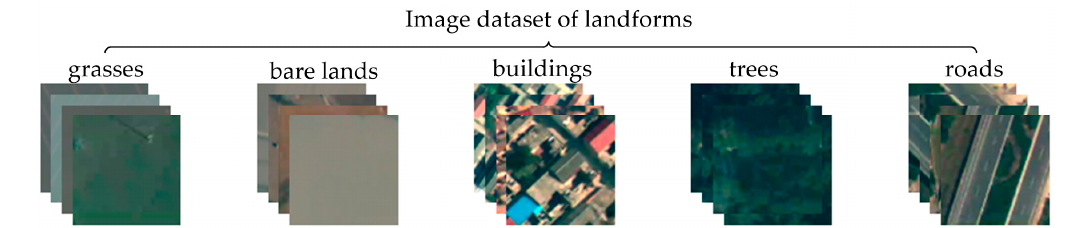
Figure 7. Image dataset of landforms. The landforms are categorized as buildings, trees, grasses, bare lands, and roads.